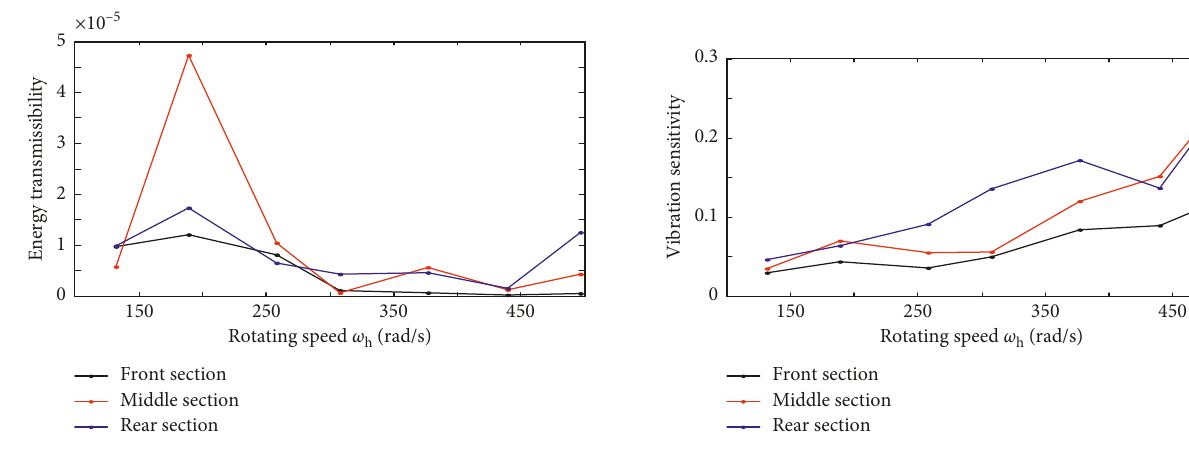
Figure 19: Experimental vibration sensitivity S with varying ro- tating speed of high-pressure rotor ω h : front section (black), middle section (red), and rear section